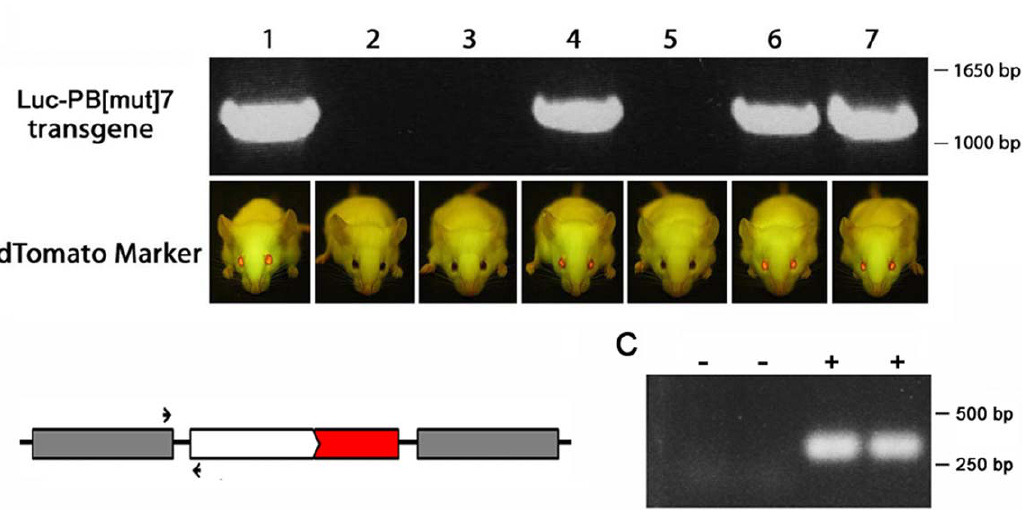
Figure 3. Co-segregation and co-integration of fluorescent eye marker and transgene. (A) tdTomato fluorescent eye marker co- segregates with and accurately marks the presence of an unrelated transgene ( Luc-PB[mut]7 ). One litter of pups numbered 1-7 is shown. The unrelated transgene was amplified by PCR (upper panel) and the tdTomato marker was visualized under the GFP flashlight in room light (lower panel). (B) Schematic drawing of PCR strategy. One PCR primer (small arrows) was designed against the 3 9 end of the Luc-PB[mut]7 transgene (gray box) and the other primer against the a A-crystallin promoter (white box) driving the tdTomato marker transgene. (C) The hybrid PCR product from the transgene concatamer is present in two transgenic animals ( + ) but not wildtype littermates ( 2